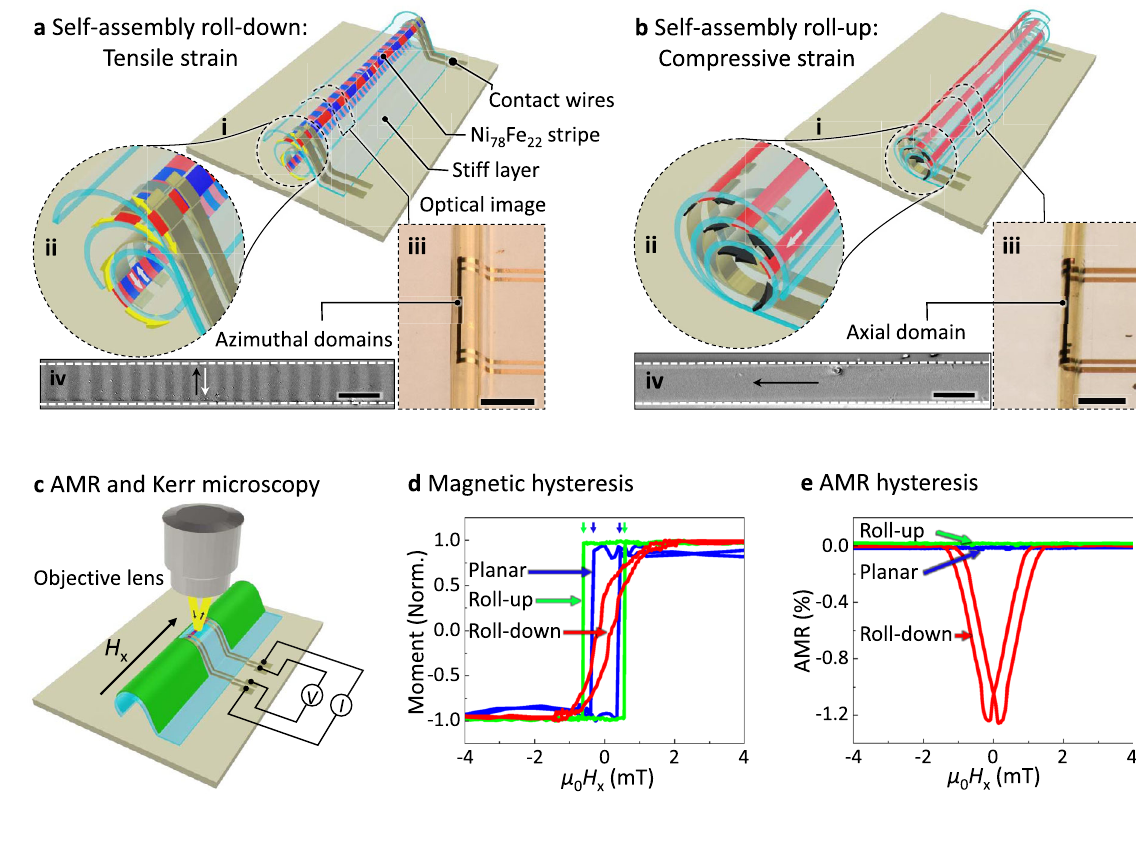
Fig. 1 Self-assembly rolling approach to study strain-induced changes in magnetic properties. Schematic illustration of self-assembly a - i roll-down and b - i roll-up approach for adjusting sign and size of curvature and strain in a functional layer on top of the polymeric platform (PP). a - ii , b - ii Magni fi ed view of the rolled structures, indicating tensile (yellow arrows) and compressive (black arrows) strain in the magnetic layer and illustrating the corresponding azimuthal and axial domain states. a - iii , b - iii Optical image of rolled-down and rolled-up polymer structure with contacted Ni 78 Fe 22 stripe (scale bar, 200 µm) and a - iv , b - iv corresponding Kerr microscopical image of the domain state. Scale bar, 15 µm. c Schematic set-up of simultaneous magneto-optical and AMR measurement of a strained magnetic stripe lying on the dome of the polymeric tube. d Magnetic hysteresis and e AMR hysteresis were measured simultaneously on the Permalloy (Ni 78 Fe 22 ) stripe with fi eld along the stripe ’ s long axis ( x -axis) before and after